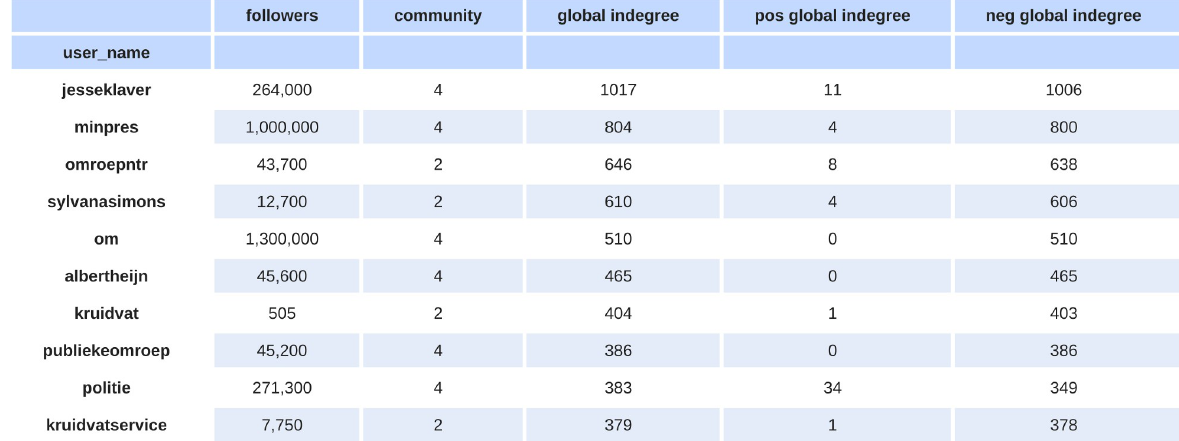
Fig 3. Top missing users. The top 10 users of the signed network that are not in the retweet network. These top ten users are not in the retweet network at all—also not in the smaller or isolated communities. The column statistics are based on the signed network. The follower counts are